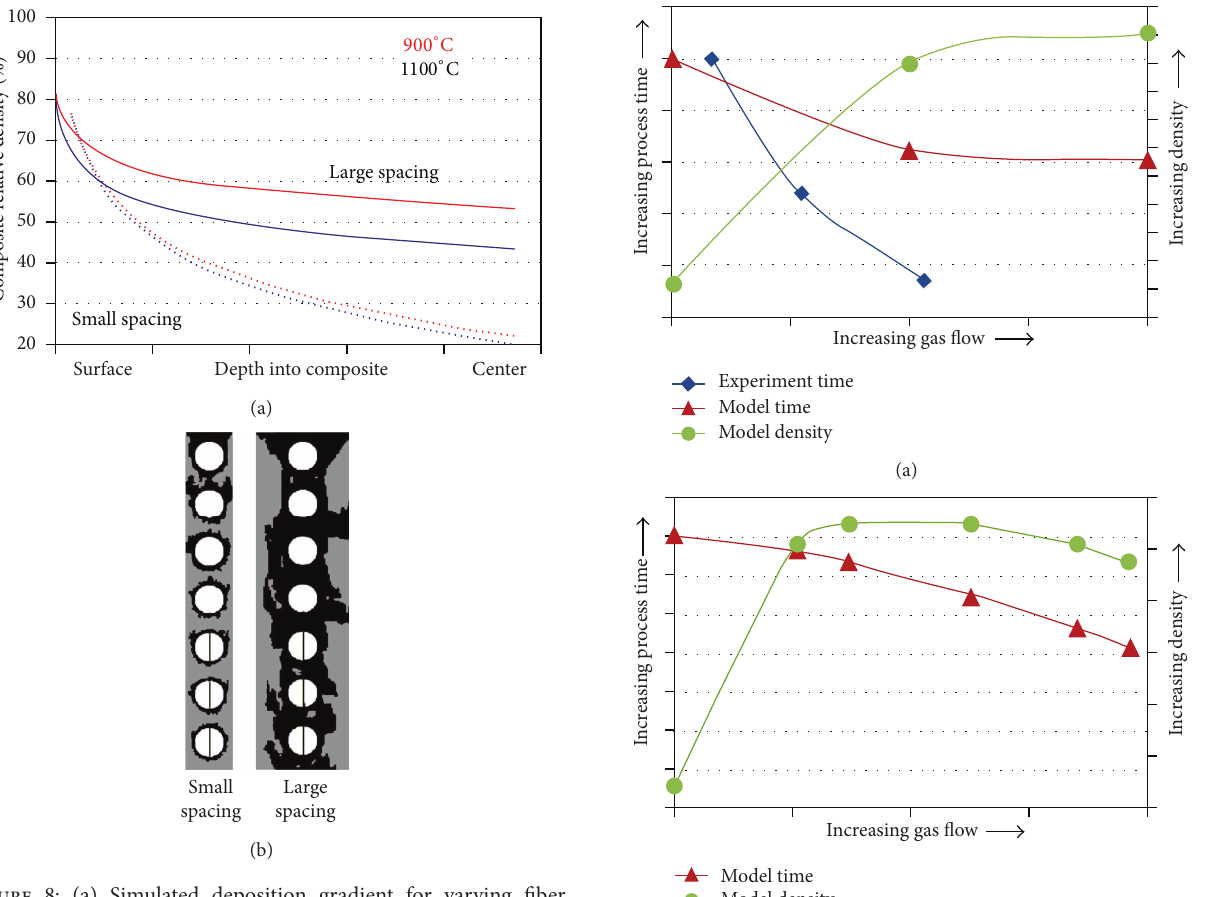
Figure 8: (a) Simulated deposition gradient for varying fiber spacings and temperatures, (b) simulated infiltration for small and large fiber spacing, where black indicates deposited SiC matrix around white fiber cross-sections. Figure 9: (a) Simulation and experimental results from the current